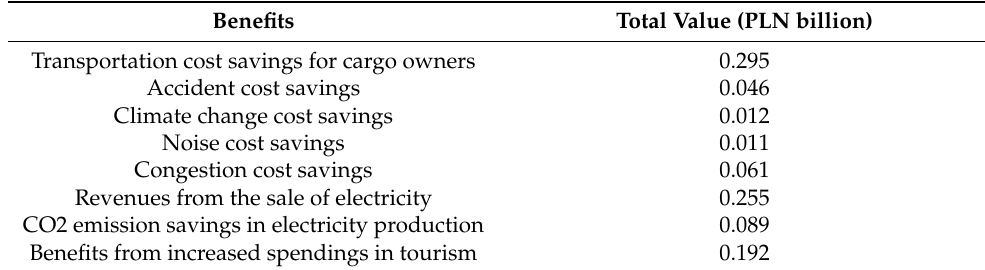
Table 6. Other economic benefits of the functioning of the barrages on the Lower Vistula downstream from the Włocławek reservoir in the first year of the